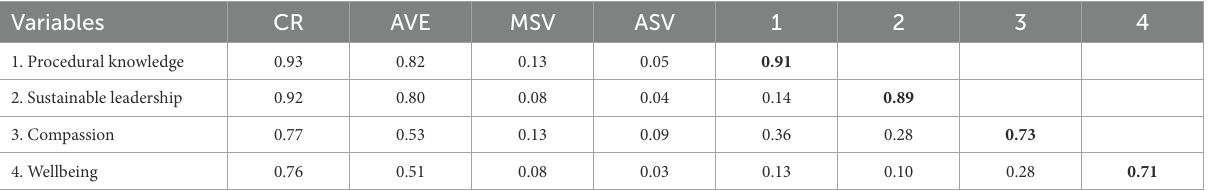
TABLE 2 Convergent and divergent